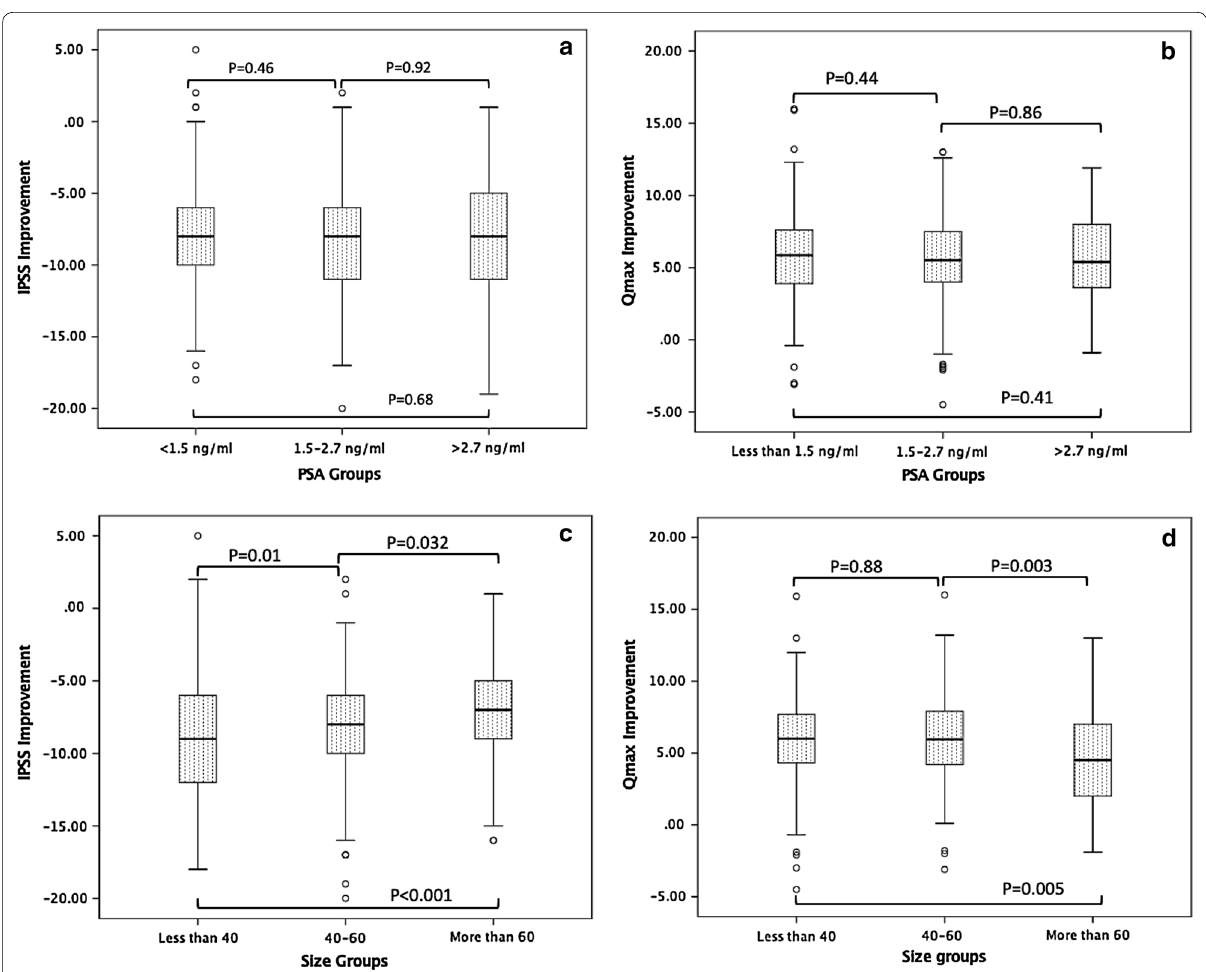
Fig. 2 Boxplot diagrams show a IPSS changes in relation to PSA groups, b Qmax changes in relation to PSA groups, c IPSS in relation to PV groups, d Qmax improvement in relation to PV groups